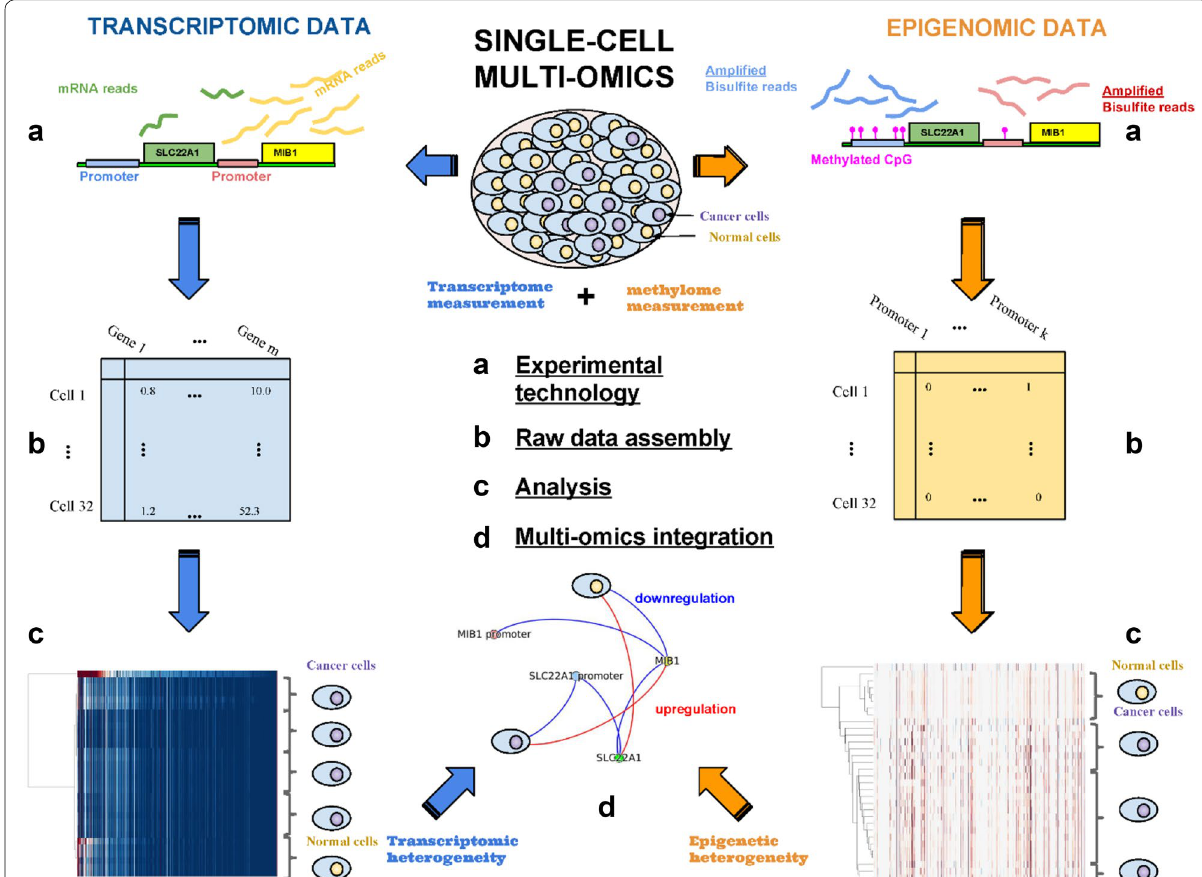
Fig. 4 Single-cell multi-omics analysis workflow. a Multi-omic technologies can produce reads from the transcriptome (RNA-seq), the genome (exome sequencing), and/or the methylome, from the same cells. b Read alignments, quality control (QC), and specific processing steps create “feature expression” matrices, where cells are represented as vectors and genomic features (e.g. gene expression, methylation) represented as col- umns. c The different omic matrices can then be analyzed independently, for detecting cell subpopulations and ranking the genomic features etc. d Finally, multi-omics integration can be performed to identify coherent features from different omics that separate different